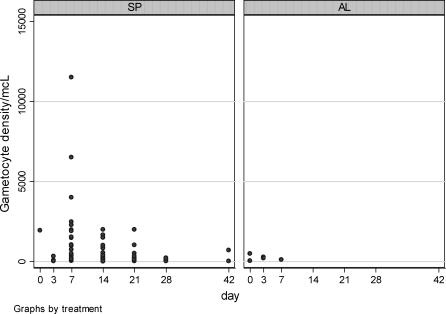
Scatter Plot of Individual Patient Gametocyte DensitiesThe gametocyte densities (per microlitre) are given over time following treatment with SP (2000) and AL (2002).